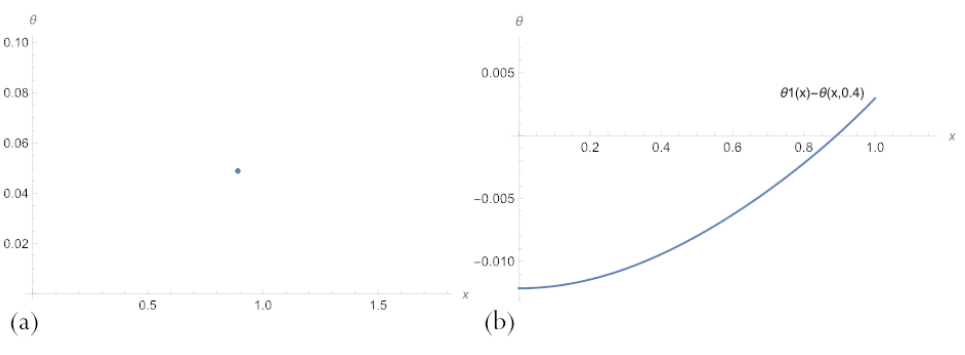
Figure 13. Parameter identification and model discovery. ( a ) A sample with K = 3 synthetic measurements; ( b ) error in corresponded parametric PBA-PINN solution (20) to (11) for predicted parameter δ value.